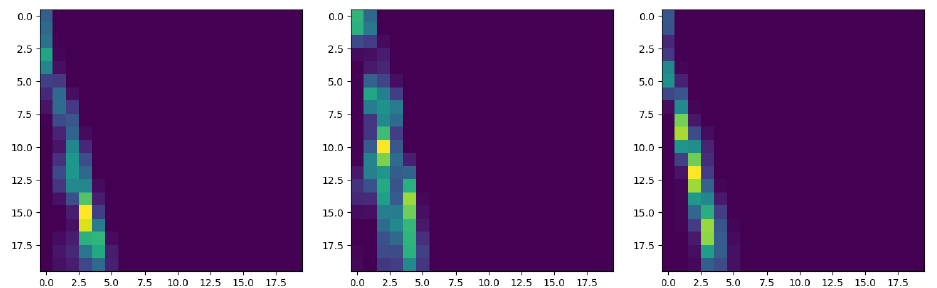
Figure 10. Persistence images related to three roughness profiles, each extracted from one of the three composite sheets.